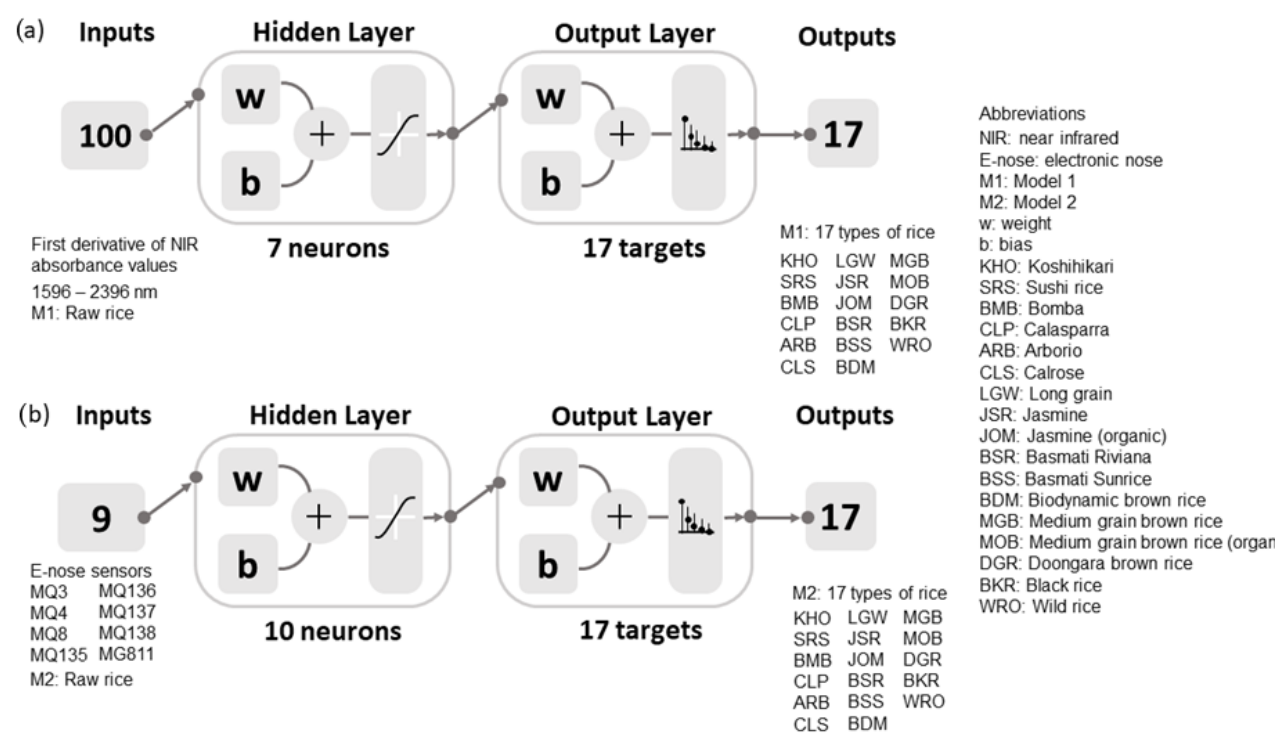
Figure 1. Classification models developed using ( a ) the first derivative of NIR absorbance values as inputs (Model 1) and ( b ) electronic nose sensors ’ data as inputs (Model 2) to classify the 17 types of commercial rice. A description of the electronic nose sensors can be found in Table 2.